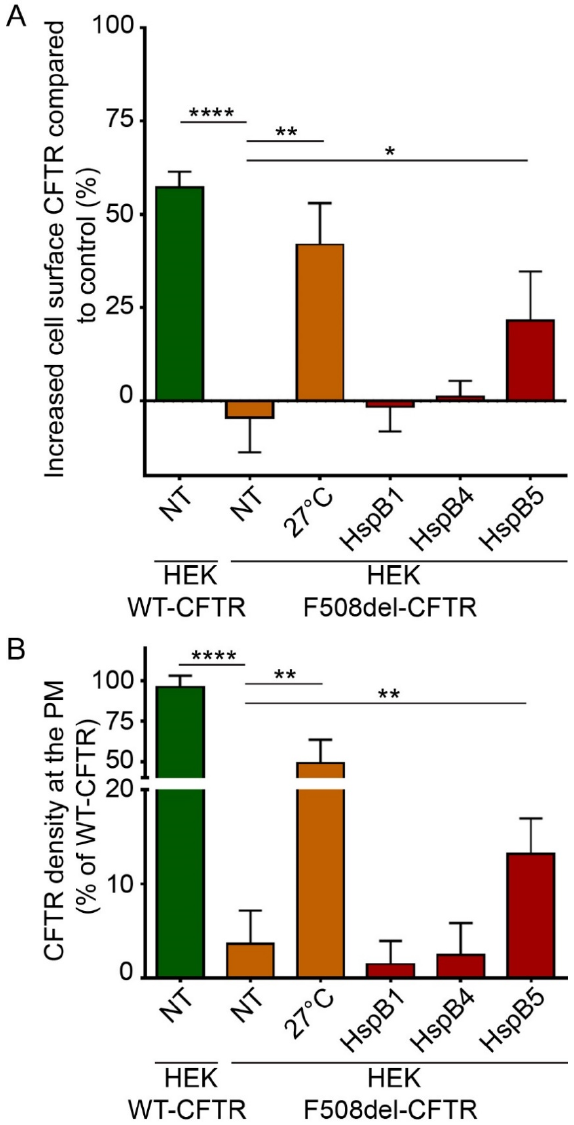
Figure 3. Impact of overexpression of HspB1, HspB4, or HspB5 on localization at the plasma membrane (PM) of F508del-CFTR in human embryonic kidney HEK293 GripTite (HEK) cells. HEK cells stably expressing F508del-CFTR-3HA were transfected with a HspB1, HspB4, or HspB5 construct. Cells were used 24 h post-transfection for detection of PM CFTR ( n = 5). Untransfected F508del-CFTR-3HA HEK (NT) were used as a negative control. Untransfected F508del-CFTR-3HA HEK cultivated